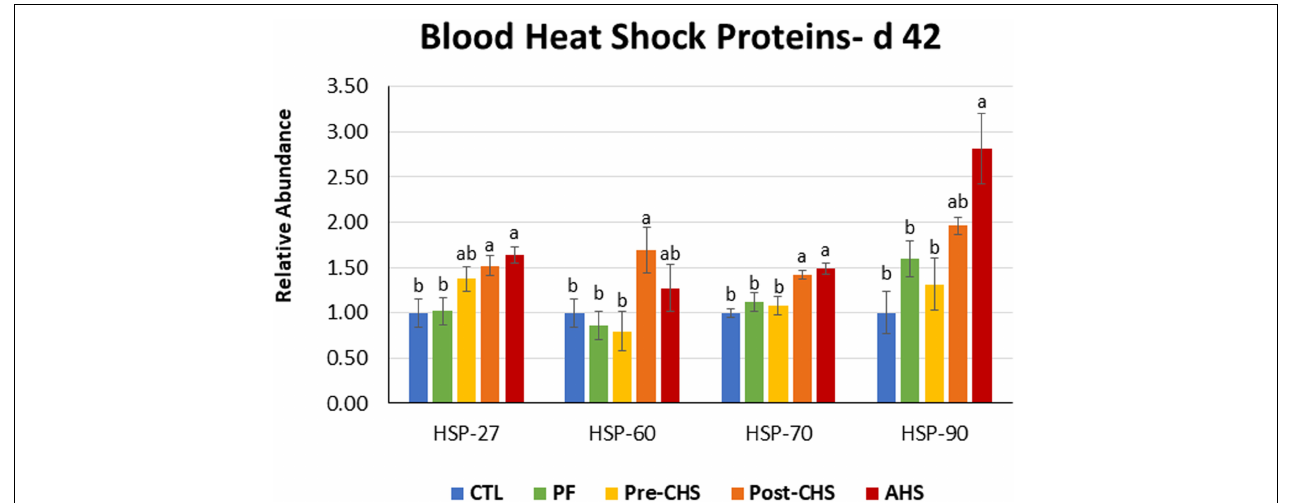
FIGURE 4 | Relative mRNA abundance of heat shock protein ( HSP )- 27 , HSP60 , HSP70 , and HSP90 in the blood of Cobb 500 male broiler chickens on day 42. Birds in all the groups were raised under the recommended conditions from day 0 to 28. Treatments include: (1) control (CTL): birds raised under thermoneutral condition (23 ◦ C) from day 29 to 42; (2) AHS: birds raised under thermoneutral condition (23 ◦ C) from day 29 to 42, but exposed to 2 h AHS (35 ◦ C) before sampling on day 42; (3) Pre-CHS: birds exposed to high ambient temperature (35 ◦ C) for 8 h/day (9:30 am–5:30 pm) from day 29 to 42, and sampled before starting the CHS; (4) Post-CHS: birds exposed to high ambient temperature (35 ◦ C) for 8 h/day (9:30 am–5:30 pm) from day 29 to 42, and sampled 2 h after starting the CHS; (5) pair-fed (PF): birds raised under thermoneutral condition (23 ◦ C) from day 29 to 42, but pair-fed to CHS group (these birds received each day 1.05 times the average feed intake recorded in the CHS group in the previous day). Values are represented as a n -fold difference relative to the calibrator (CTL). Results are given as means ( n = 8) for each group. Error bars indicate standard errors. For each gene, bars with different letters are significantly different ( P < 0.05).